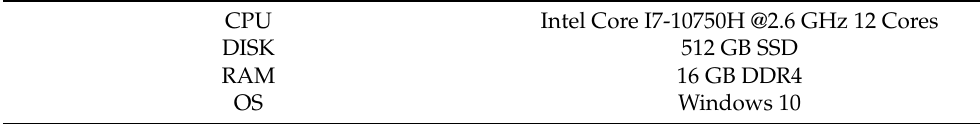
Table 1. Computer